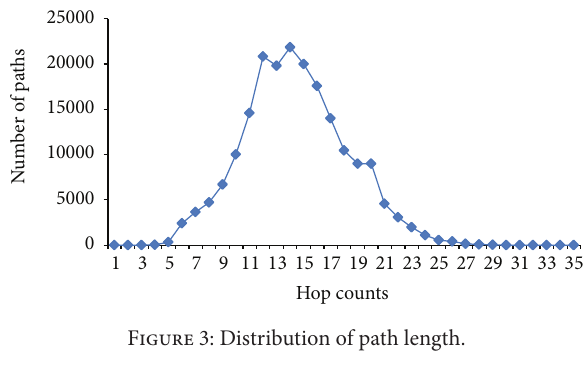
Figure 3: Distribution of path length.